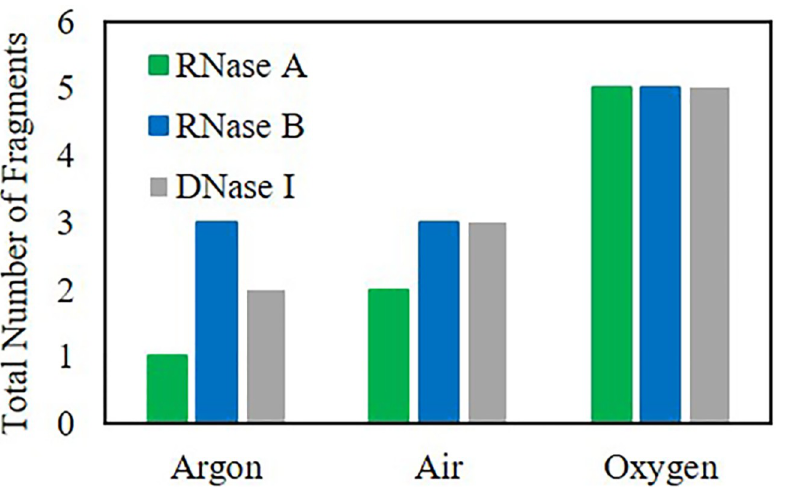
Fig 2. Total number of fragments observed for RNase A, RNase B, and DNase I lysed with Lyse-It at 30% power, 60 seconds using the Agilent 2100 Bioanalyzer system. As oxygen content increases, the number of nuclease fragments also